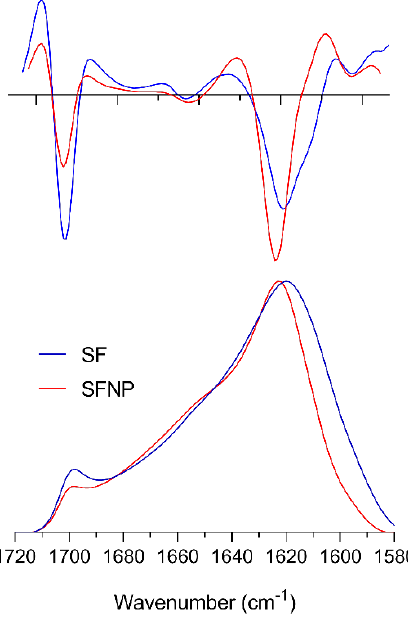
Figure 5. Infrared spectrum and its second derivative of SF fibers (blue) and SFNP (red). Top: second derivative of absorbance, bottom: normalized ATR absorbance spectrum of the amide I band. The maximum ATR absorbance was 0.083 at 1620 cm −1 for SF and 0.248 at 1622 cm −1 for SFNP.